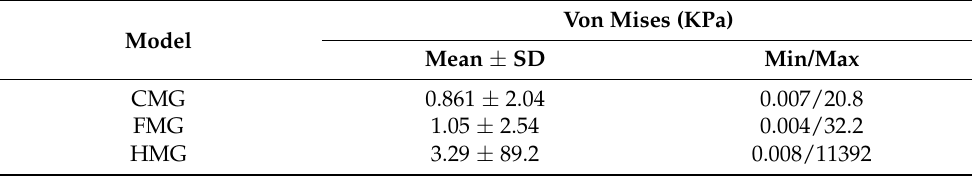
Table 8. Mean and range of stretches over the mouthguard